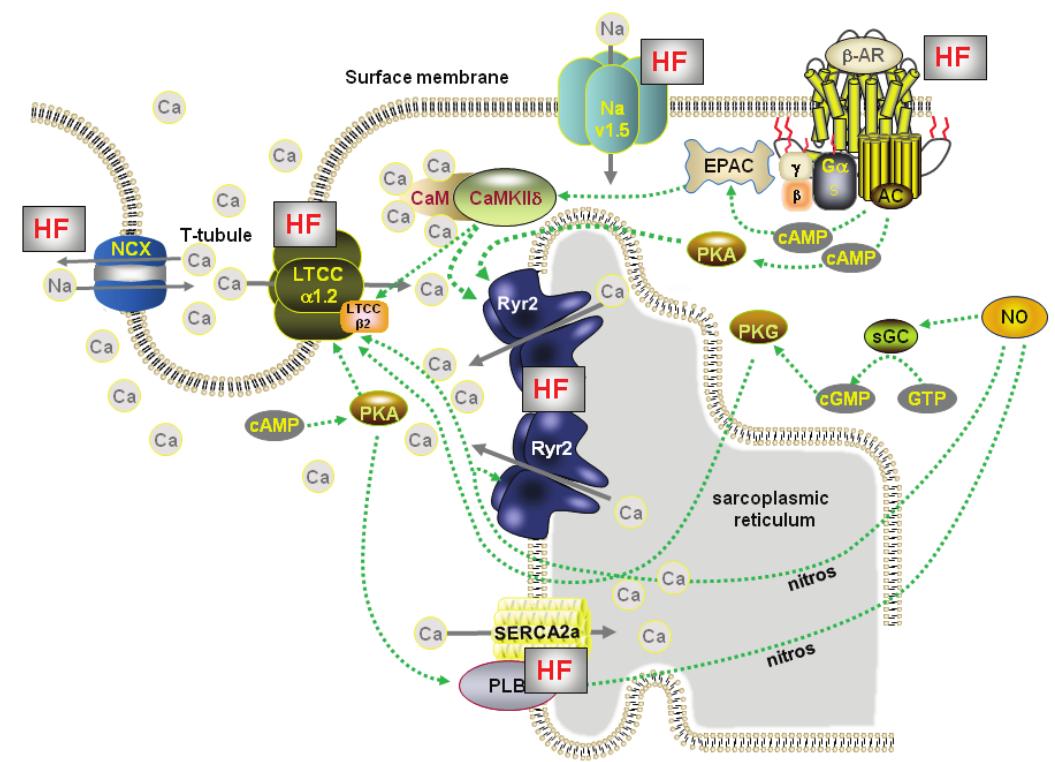
Figure 2. Schematic diagram of the main proteins involved in EC coupling in a ventricular myocyte isolated from the failing heart. The HF label signifies protein function has changed. T-tubule architecture alters resulting in less effective Ca-induced Ca release from the SR, uptake of Ca by SERCA is reduced, late Na current is increased. In addition to other changes in Na regulation this causes an increase in cytosolic [Na] that disturbs the function of NCX. Beta-adrenoceptors are down-regulated in heart failure and CaMKII activity is increased. Local decreases in protein phosphates results in hyperphosphorylation (chronic phosphorylation) of Ryr2 that destabilises the Ca release channel causing opening probability to increase. This results in greater diastolic Ca release from the SR (Ca leak) that, in parallel with reduced SERCA efficiency, lowers SR Ca